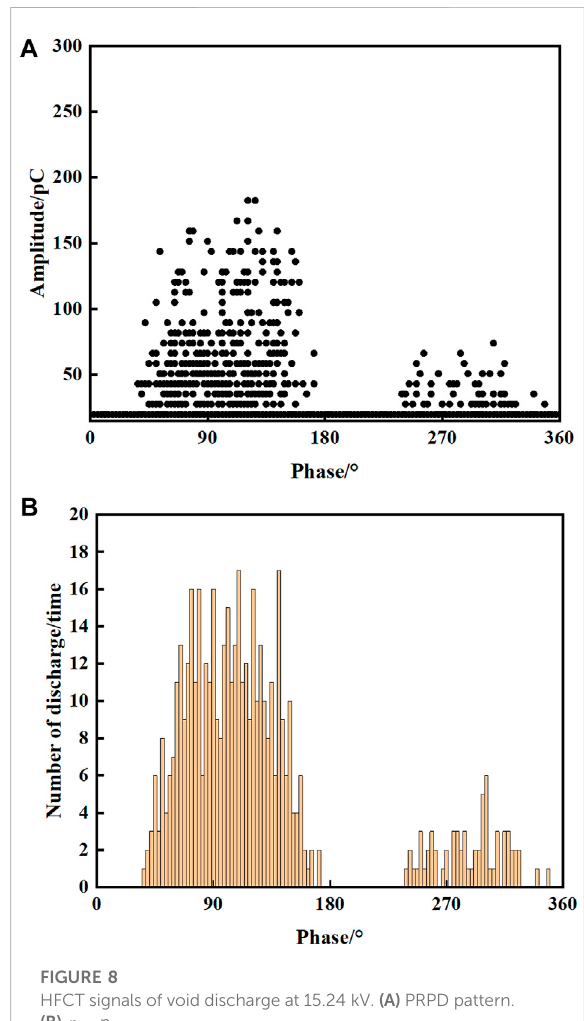
FIGURE 8 HFCT signals of void discharge at 15.24 kV. (A) PRPD pattern. (B) φ −